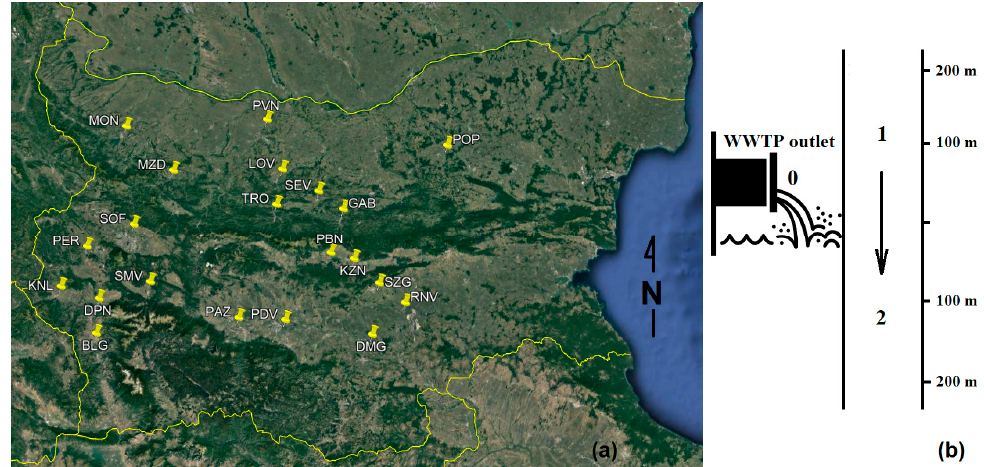
Figure 1. Sampling: ( a ) location of the wastewater treatment plants (WWTPs) and ( b ) sampling scheme (please refer to Supplementary Materials for details on sampling locations and acronyms used).